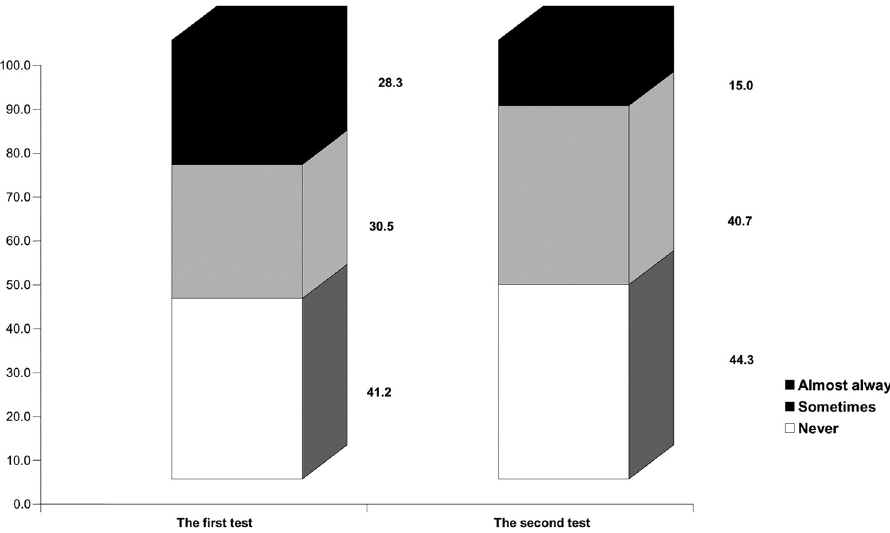
Fig 1. The structure of the frequency of patients’ answers to single items/questions of the ohip-edent-B&H questionnaire before and after interventions and corrections.